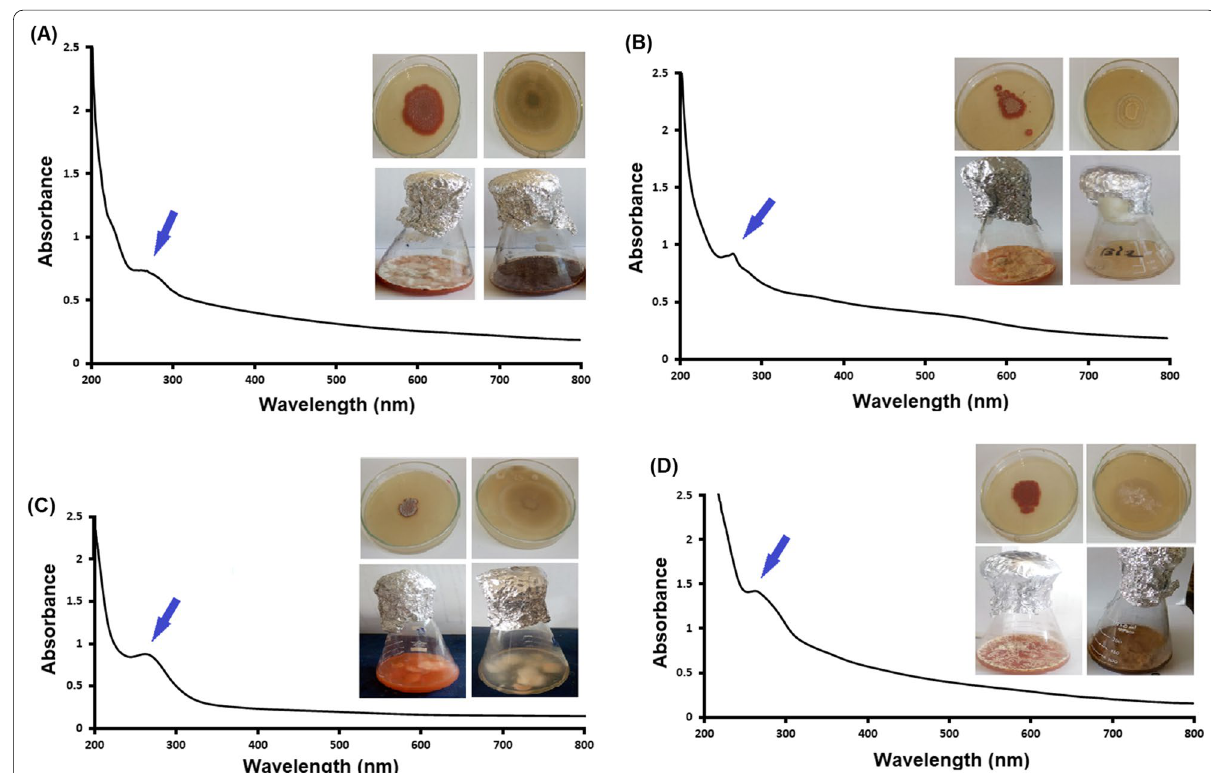
Fig. 2 UV‑Vis spectra of SeNPs. Fig. Inset shows PDA plates and PD broth flasks with (left‑handed) and without sodium selenite (right‑handed). NPs were separated from the culture broth, purified, dissolved in methanol and treated ultrasonically then the absorption was recorded in the range 200–800 nm. A UV‑Vis spectrum of SeNPs synthesized by A. quadrilineatus , B UV‑Vis spectrum of SeNPs synthesized by A. ochraceus , C UV‑Vis spectrum of SeNPs synthesized by A. terreus , and D UV‑Vis spectrum of SeNPs synthesized by F.